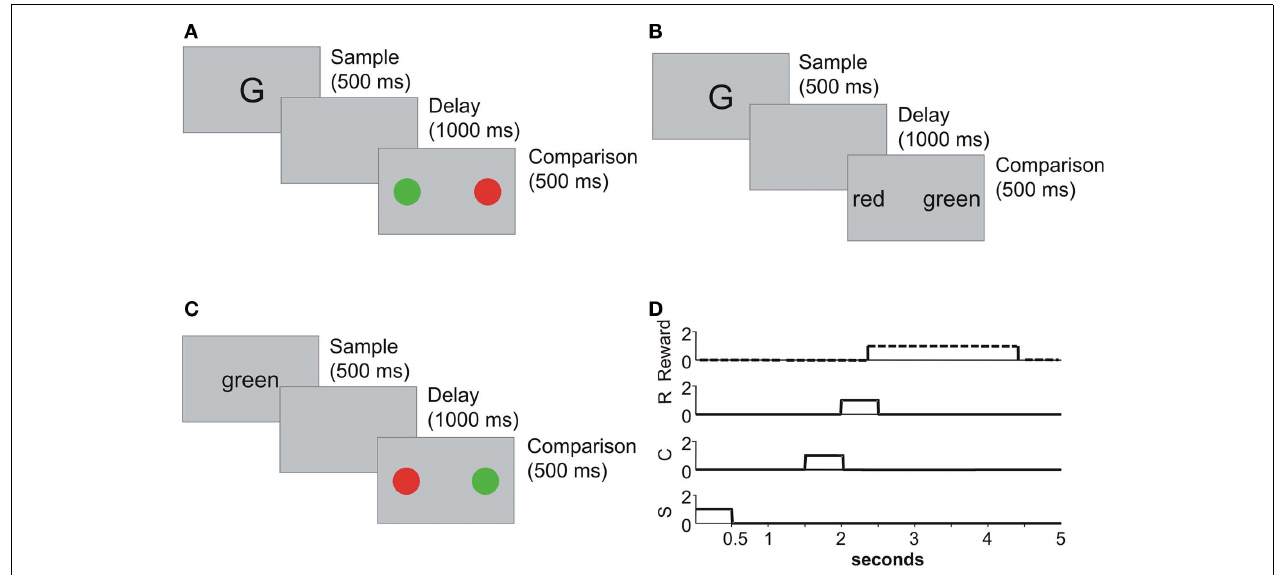
colors. (D) Stimuli timing, responses, and reward along trials. Sample stimuli (S) are presented for 500ms at the beginning of the trial. After a 1-s delay the comparison stimuli (S) are presented. Comparison stimuli are held until a response (R) is executed, or the end of the trial is reached. Every time a correct response is executed a reward is delivered. Rewards last 2s for simulation purposes.